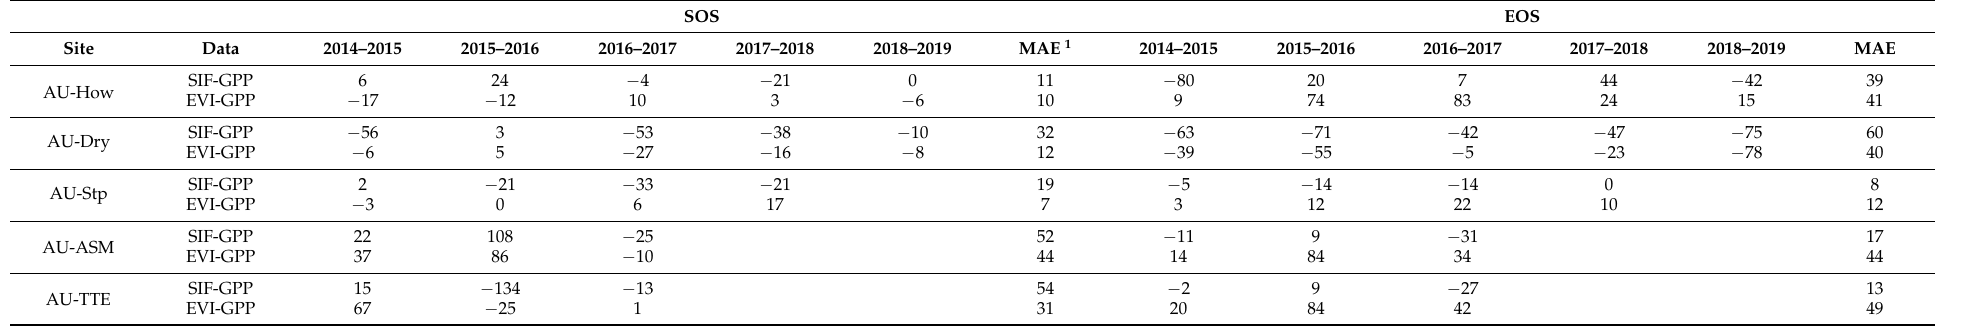
Table 1. Summary of differences (days) in SOS and EOS derived from SIF, EVI compared with that derived from tower-based GPP. Negative values represent an earlier green-up (SOS) or senescence (EOS) of SIF, EVI relative to that of GPP.